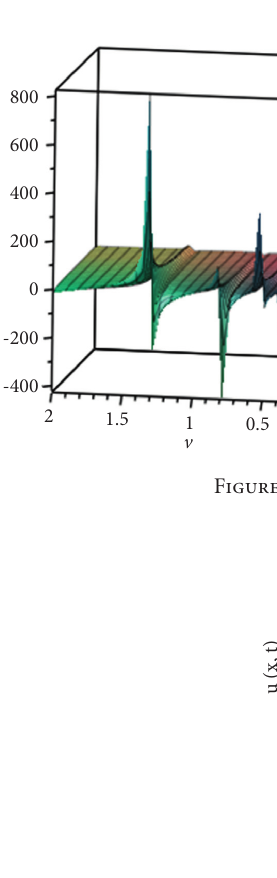
given in (16) for α � 10 and ] � 2